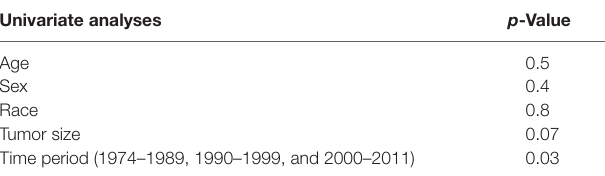
TaBle 2 | Factors associated with radiation.